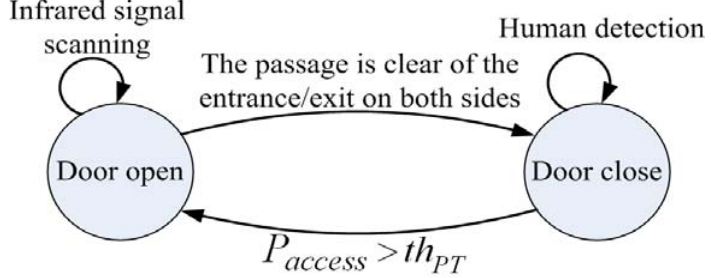
Figure 2. The state transition diagram of the